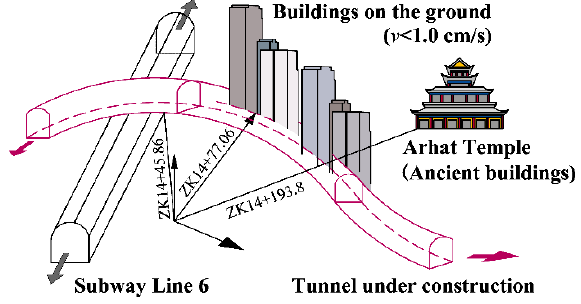
Figure 3. Buildings around the tunnel.